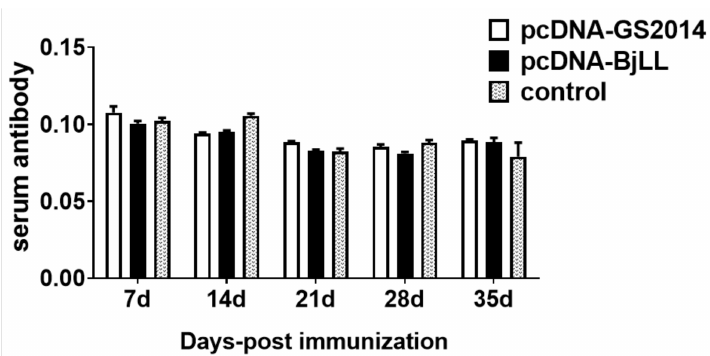
Figure 6. Detection of NAbs in serum. The NAbs in serum at days 7, 14, 21, 28, and 35 after immunization were measured by ELISA. Graphs are shown from three independent